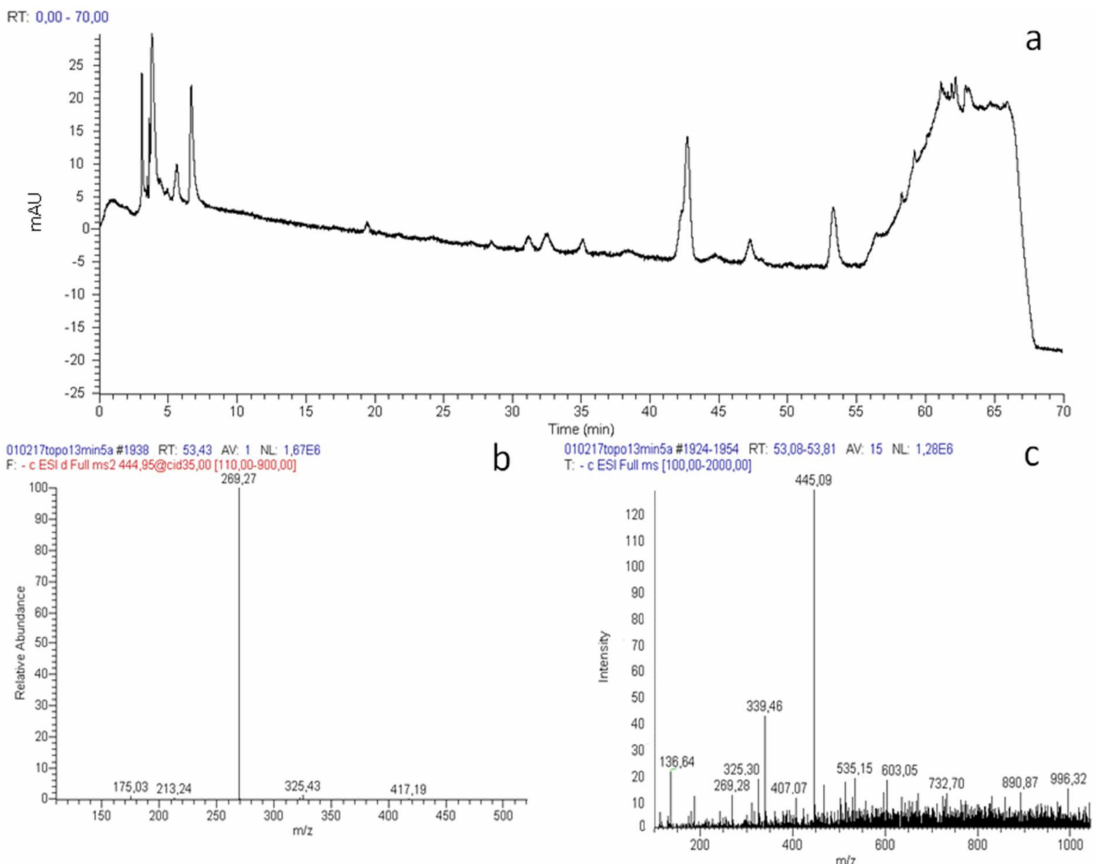
Figure 1. ( a ) The chromatogram of the blood sample collected after 5 min of acute treatment on mouse 13 is shown. ( b ) The MS spectrum is relative to the peak with a retention time of 53.34, which is galangin–glucuronide. ( c ) This MS/MS spectrum describes the fragmentation of galangin–glucuronide with m/z 445: the parent ion, detected in negative ionization mode, produces the fragments at m/z 269, 157, 305 and